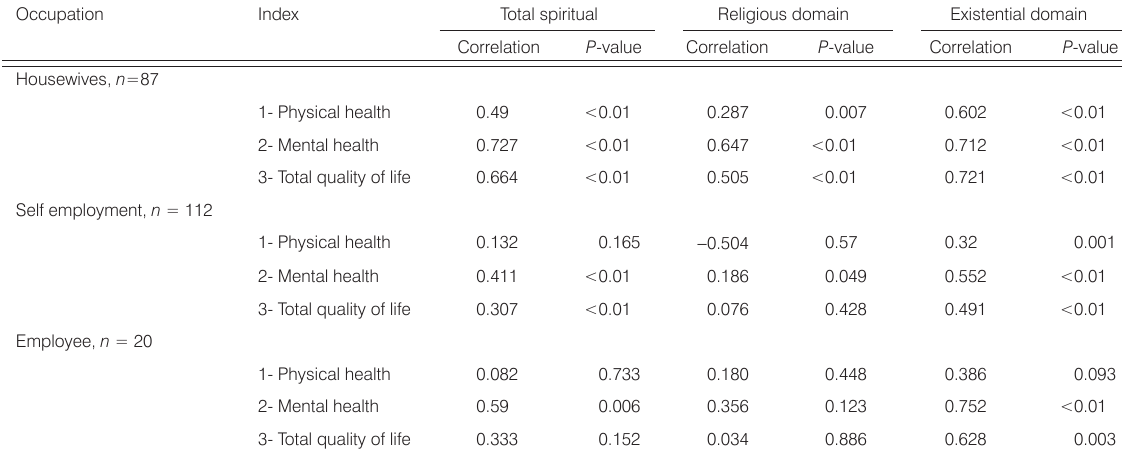
Table 3. The relationship between spiritual well-being and QoL dimension according to